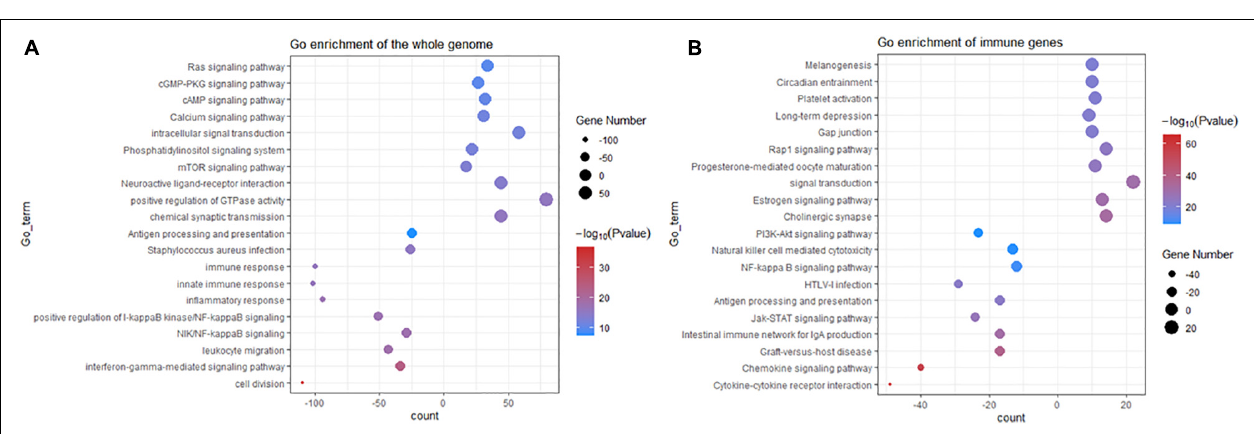
FIGURE 2 | GO analyses of upregulated gene set enrichment according to TERT mutation in IDHwt gliomas (including KEGG). (A) GO analyses enrichment pathways for differentially expressed genes from the whole RNA-Seq genes among IDHwt gliomas. (B) GO pathway analyses for differentially expressed immune genes among IDHwt gliomas; Plot size shows gene counts on enrichment of pathway; Color depth shows the –log10p value from low level (blue) to high (red); significant p <